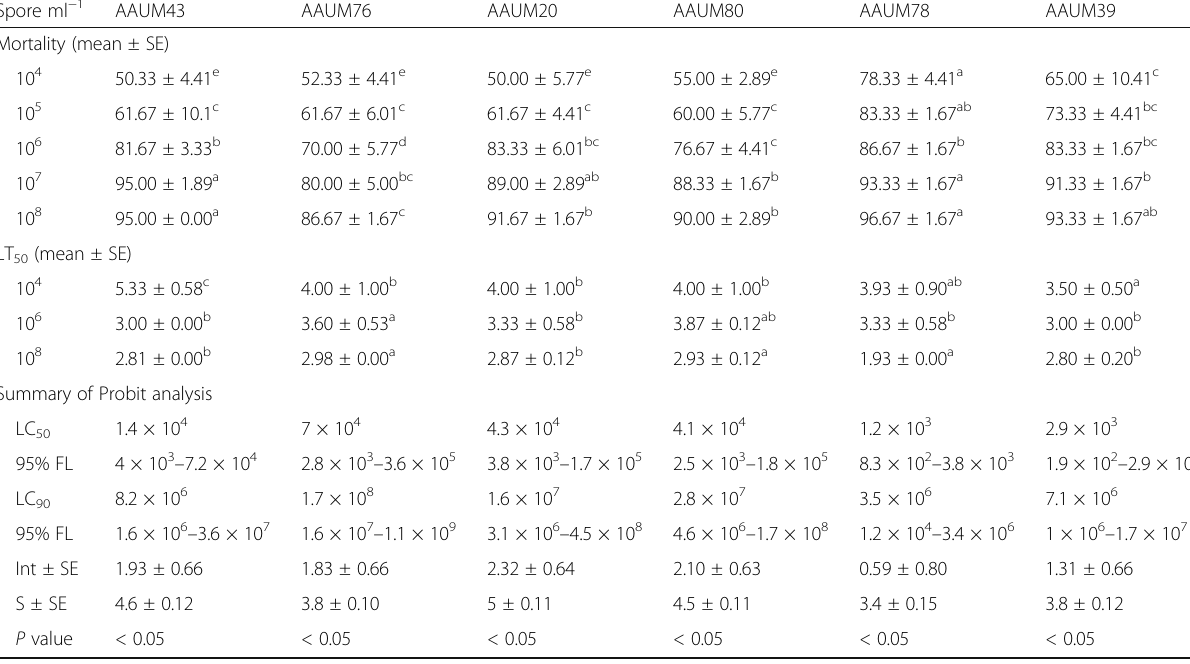
Table 3 Summary of Probit analysis, calculated lethal time, and concentration-mortality response at 10 days of post inoculation to third larval instar of Tuta